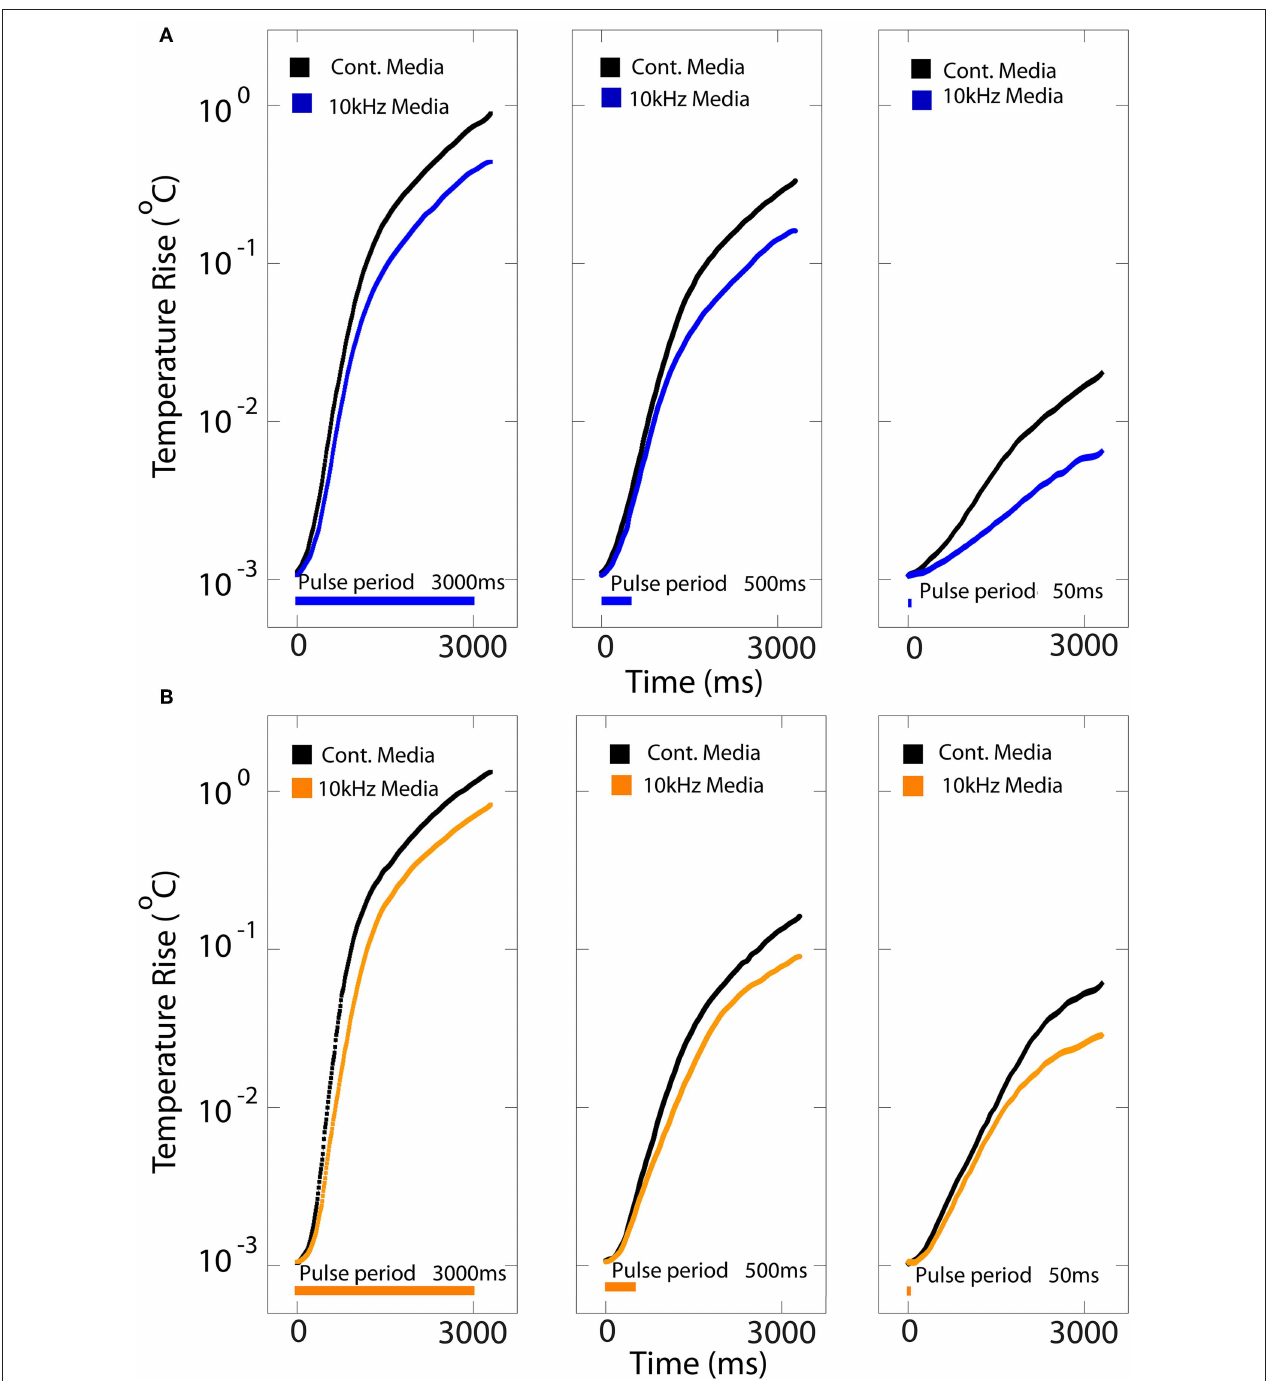
FIGURE 3 | Heating profile of blue and orange OLEDs. The steady-state temperature rise at the surface of a coverslip positioned onto the blue (A) and orange (B) OLEDs immersed in cell-culture medium vs. time for either DC (cont.; black traces) and 10kHz square-wave (colored traces) stimulation at 30V optical power corresponding to for blue and for orange OLEDs for pulse durations of 50, 500, and 3,000ms.